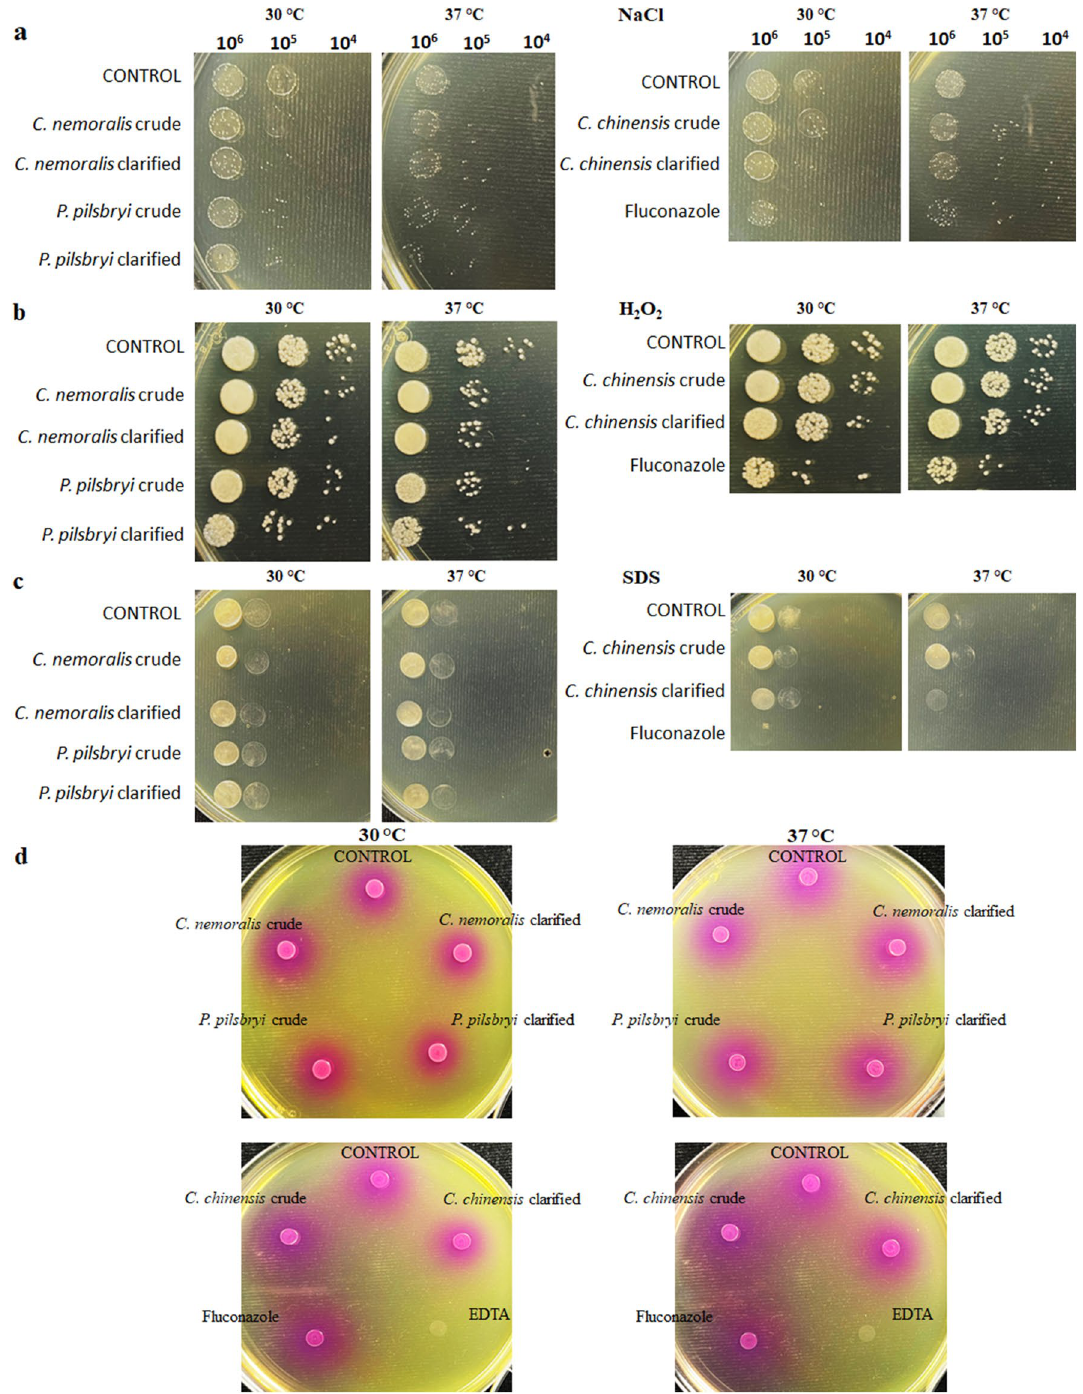
Figure 6. Effect of protein extracts on stress response and urease production for C. neoformans . Images show C. neoformans growth in YPD-agar supplemented with different stressors or Christensen’s Urea Agar after 4 h incubation with protein extracts from C. nemoralis crude (29 µg/mL), C. nemoralis clarified (35 µg/mL), C. chinensis crude (160 µg/mL), C. chinensis clarified (40 µg/mL), P. pilsbryi crude (40 µg/mL) and P. pilsbryi clarified (40 µg/mL). ( a ) Osmotic stress was performed with NaCl at 1.5 M. ( b ) Oxidative stress was performed with H 2 O 2 at 3 mM. ( c ) Membrane stress was performed with SDS 0.01%. ( d ) Urease secretion assay. Non- treated cells (Control), fluconazole-treated (8 µg/mL), or EDTA-treated (1 mM) cells were included as controls. Images taken after 48 h (stressors) and 24 h (urease) incubation at 30 °C and 37 °C. Experiment performed in biological triplicate and technical